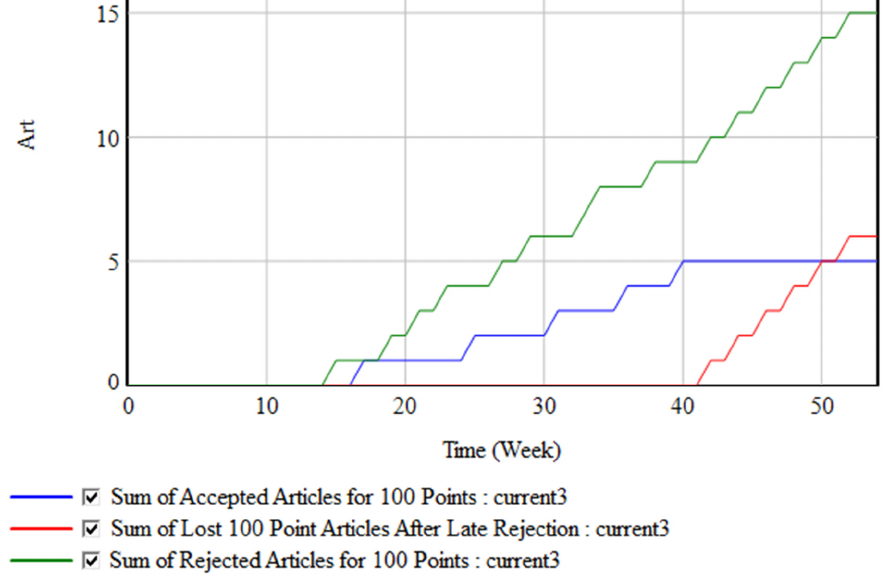
Figure 9. Results of the simulation of paper submission. The part referring to the first stage: submitting to 100-point journals and reacting to possible